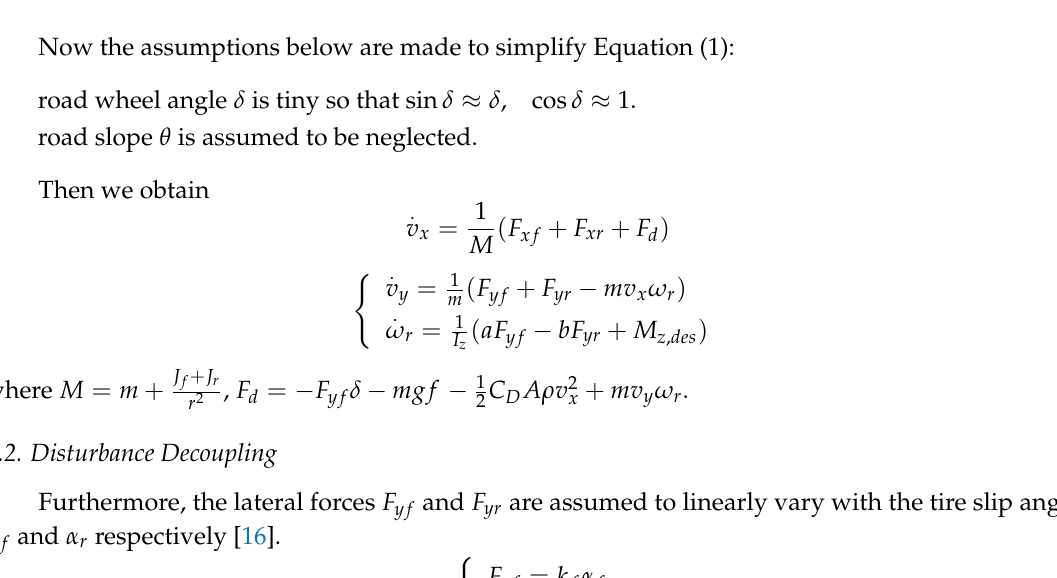
Figure 2. Schematic representing vehicle dynamics.